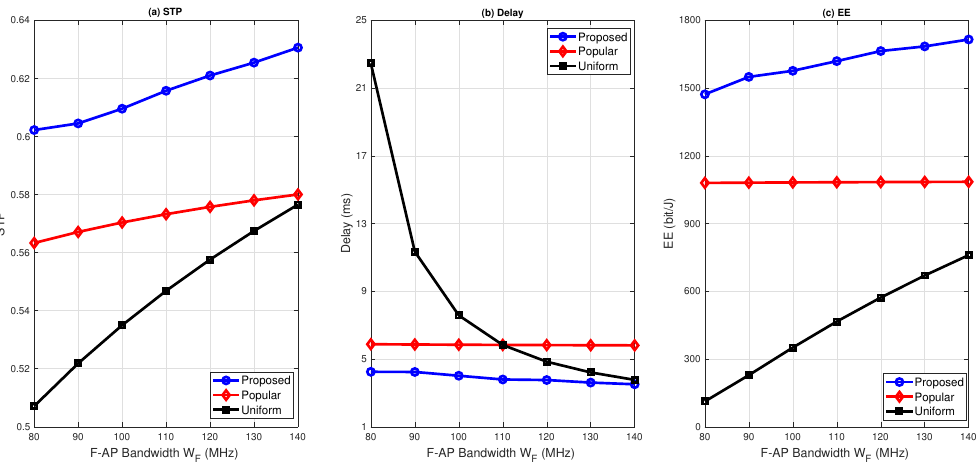
Figure 5. STP, delay, and EE versus F-APs’ bandwidth when M = 20 contents, λ U = 0.1 users/m 2 , λ F = 0.01 F-APs/m 2 , λ C = 0.0001 C-APs/m 2 , R = 150 m, γ = 0.8, α = 4, P F = 30 dBm, P C = 40 dBm, P s = 37 dBm, ρ = 15.13, W C = 500 MHz, T = 1 ms, and τ = 0.1